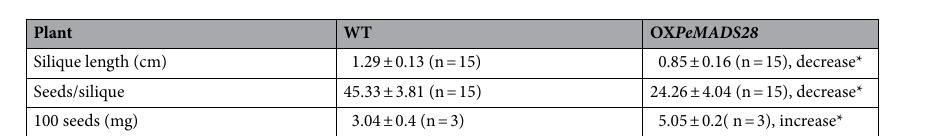
Figure 6. Phenotype analysis of transgenic Arabidopsis overexpressing PeMADS28 . ( a ) 20-day-old wild- type plant; ( b ) 20-day-old 35S::PeMADS28 transgenic plant; ( c ) 31-day-old wild-type plant; ( d ) 31-day-old 35S::PeMADS28 transgenic plant. Bars ( a – d ), 5 mm. ( e ) Side-view of wild-type flower; ( f ) side-view of 35S::PeMADS28 transgenic flower; ( g ) top-view of wild-type flower; ( h ) top-view of 35S::PeMADS28 transgenic flower; ( i ) Wild-type floral inflorescence; ( j ) 35S::PeMADS28 transgenic floral inflorescence; ( k ) cauline leaf of wild-type plant; ( l ) cauline leaf of 35S::PeMADS28 transgenic plant. Bars ( e – l ) 1 mm. ( m ) Wild-type seed (left); 35S::PeMADS28 transgenic seed (right); ( n ) silique of wild-type (upper); silique of 35S::PeMADS28 transgenic plant (lower); ( o ) silique of wild-type without one valve (upper); silique of 35S::PeMADS28 transgenic plant without one valve (lower). Bars ( m – o ) 1 mm.